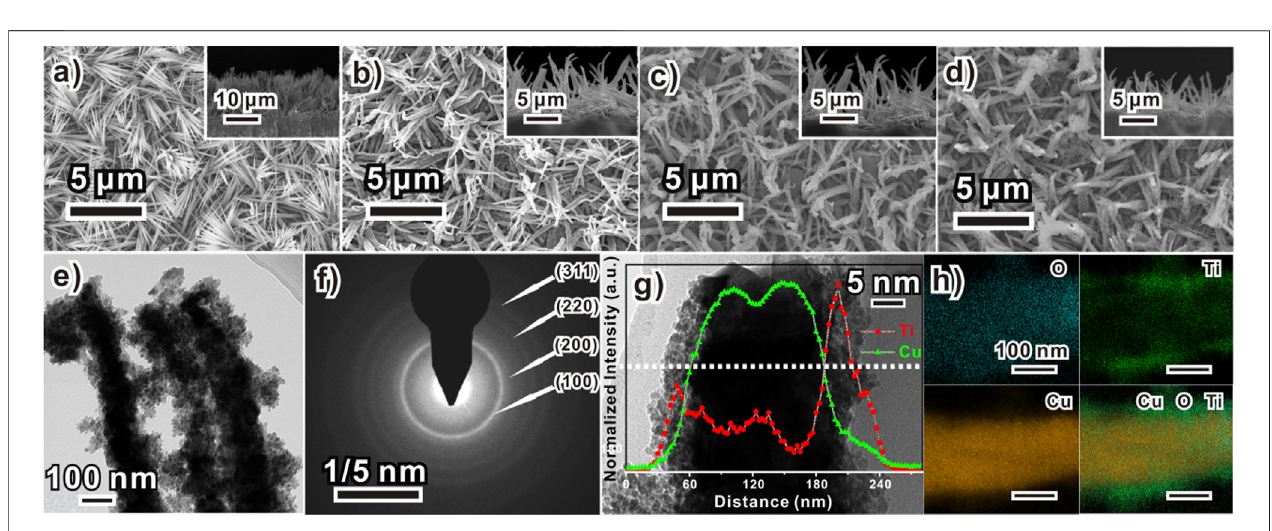
FIGURE 2 | Morphology of Cu 2 O/TiO x /Ni composite electrode formation process of a sample (A) Cu(OH) 2 NWA, (B) bare Cu 2 O NWA, (C) Cu 2 O/TiO x , and (D) Cu 2 O/TiO x /Ni (insets are their corresponding cross-section images) NWA; (E) TEM image and (F) selected area electron diffraction pattern of Cu 2 O/TiO x NWs; (G) HRTEM high magni fi cation images of Cu 2 O/TiO x NW with its line-scanned element distribution pro fi le and (H) elemental mapping of O, Ti, and Cu.